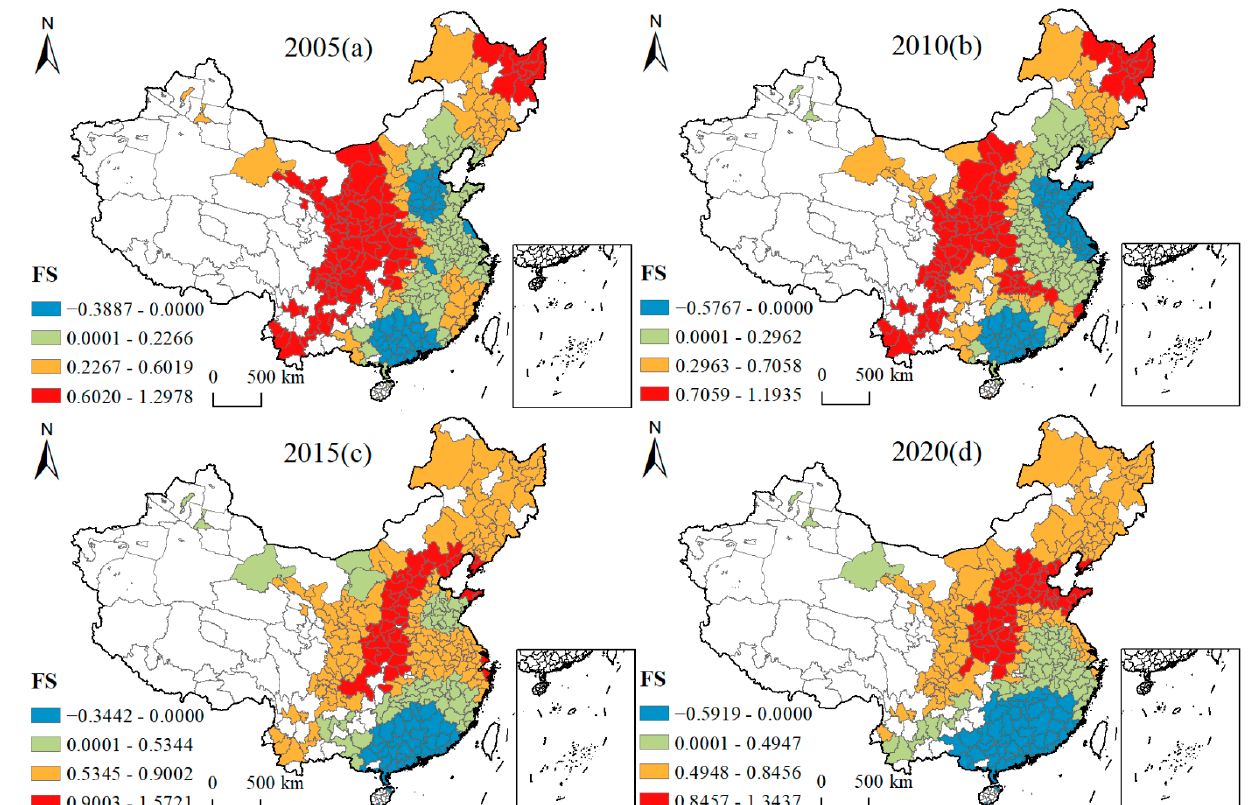
Figure 8. Four-year regression coefficients of FS.